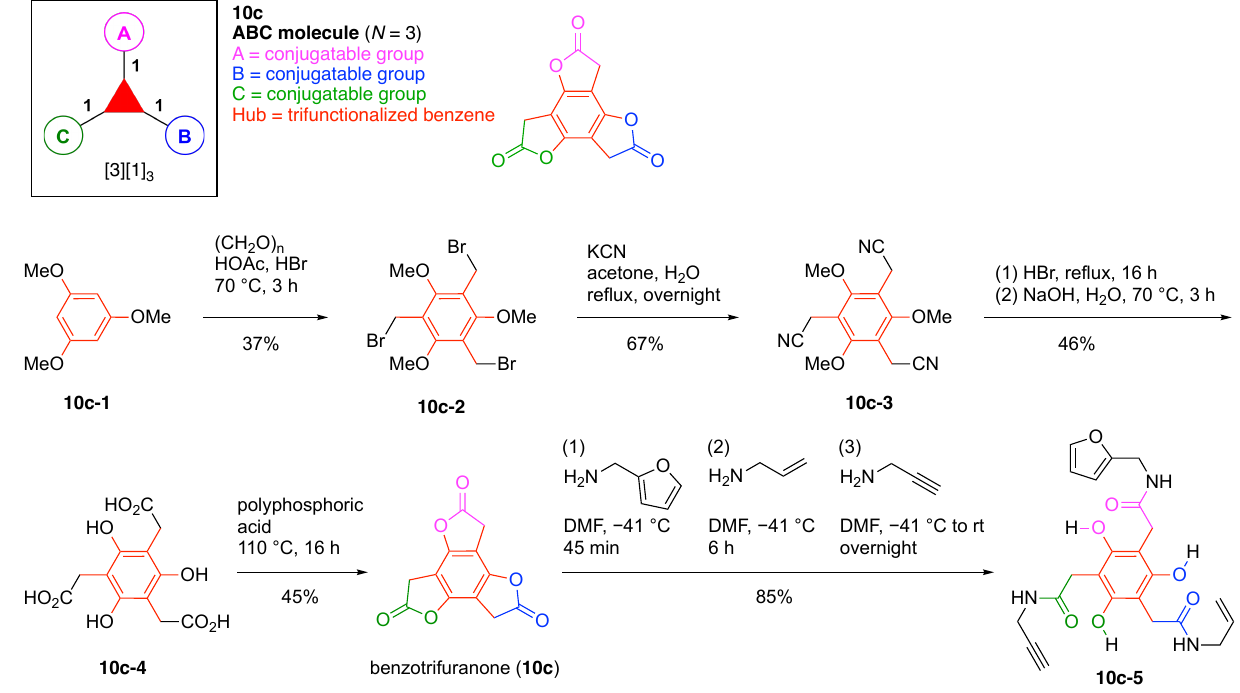
Figure 43. A benzotrifuranone scaffold affords sequential derivatization ( top ) and is formed via straightforward synthesis ( bottom ).